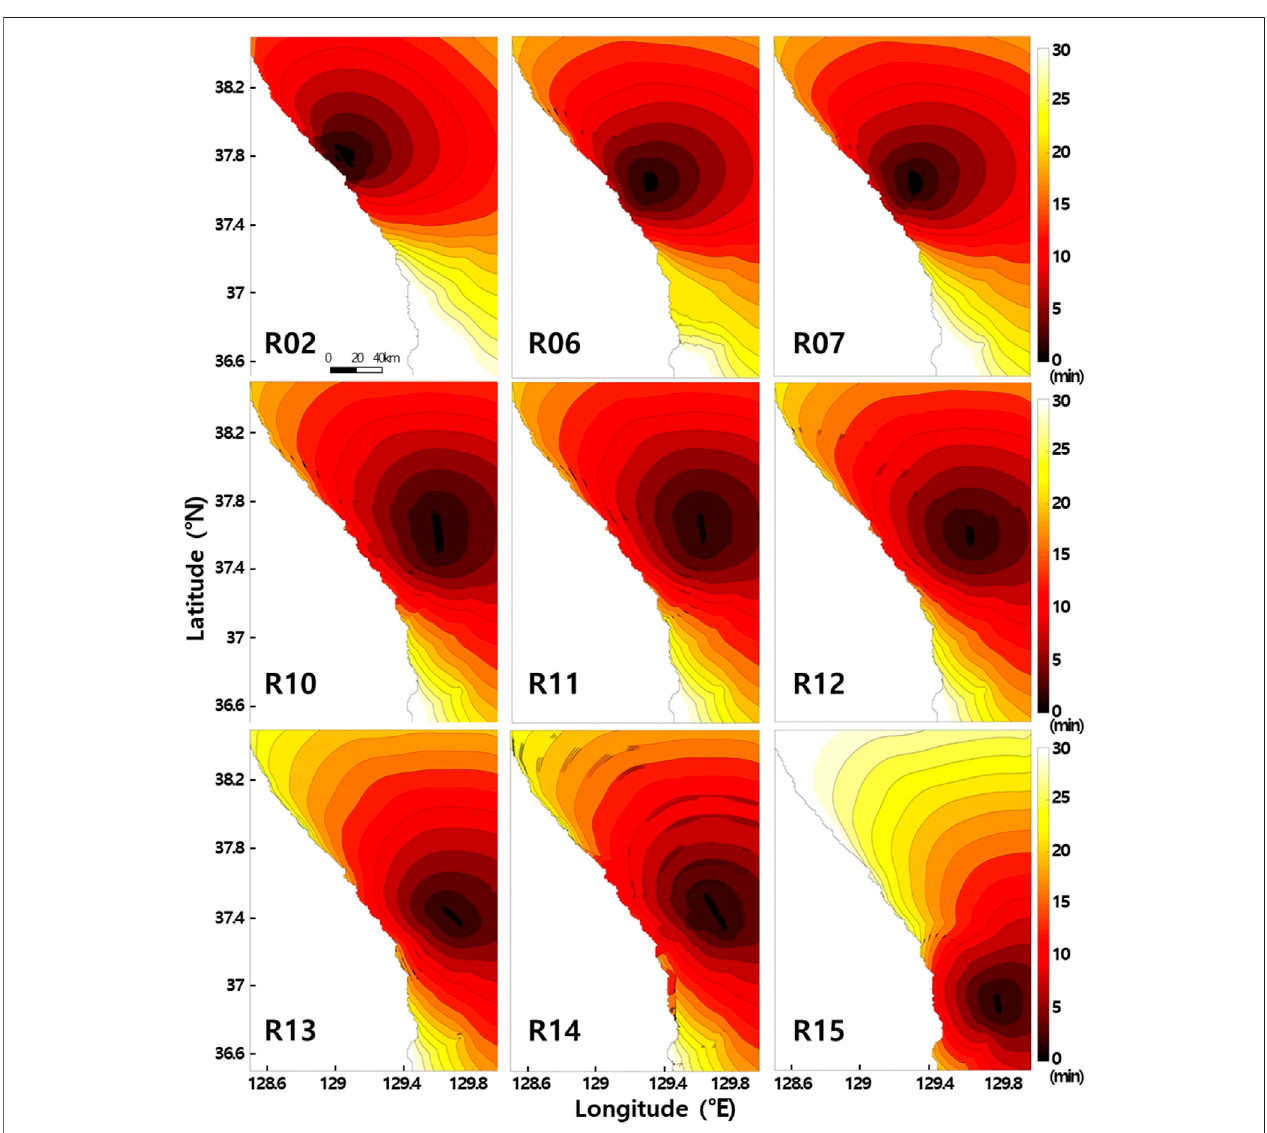
FIGURE 12 | Modeled propagation extent (distance) and arrival time to the eastern Korean coast of tsunamis generated in the East Sea for various scenarios.